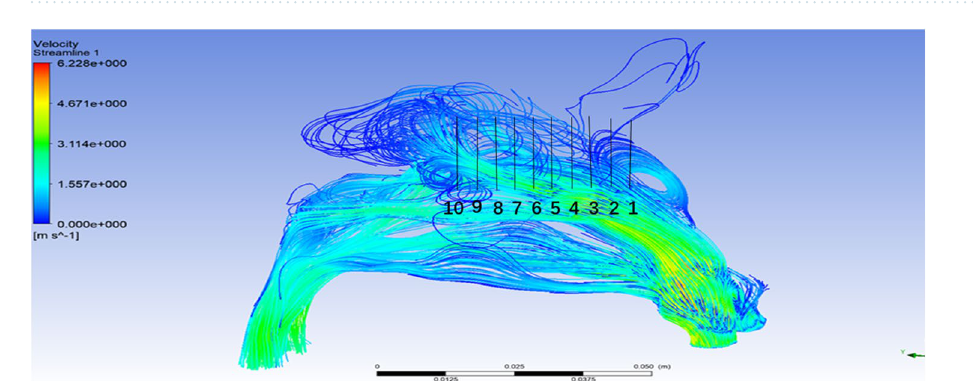
Figure 4. Airflow streamline in sagittal position(created by ANSYS 17.0: Academic Teaching Mechanical and CFD, ANSYS END USER CERTIFICATE, Sun Yat-sen University(#1016974)).